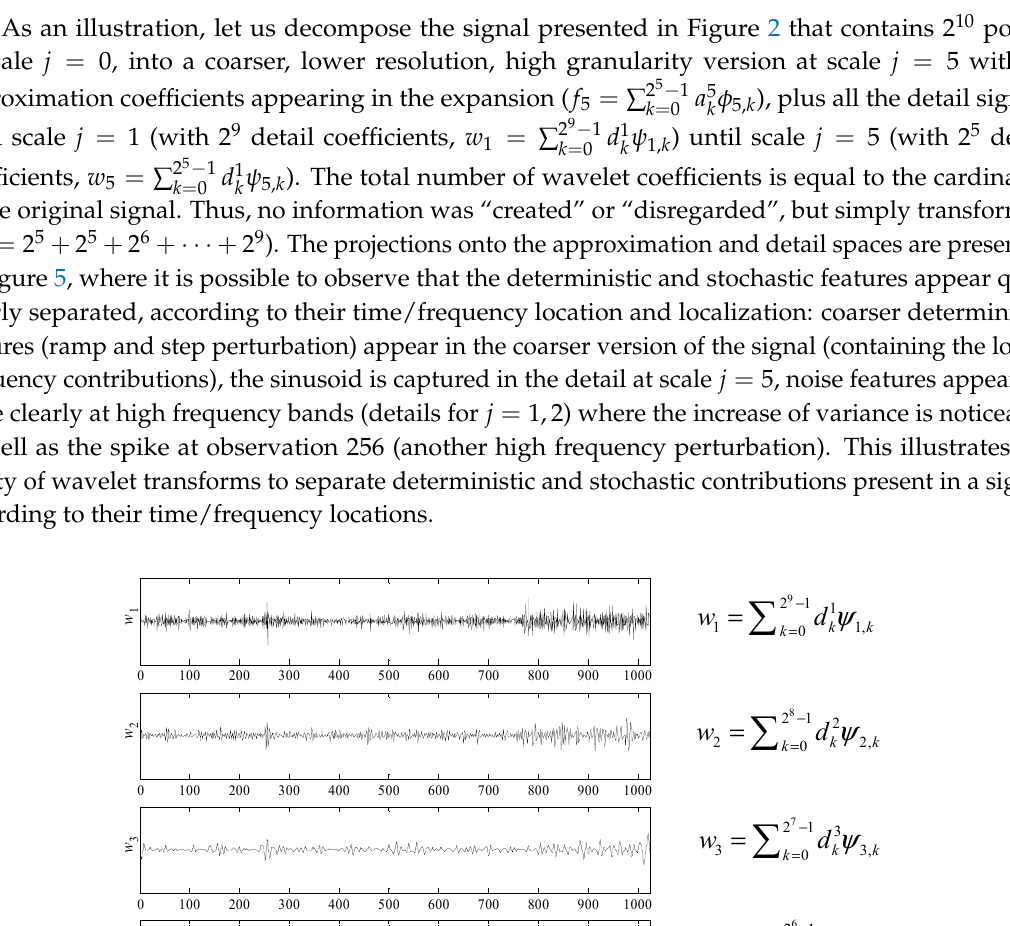
(cid:82) + ∞ t k ψ ( t ) dt = 0 − ∞